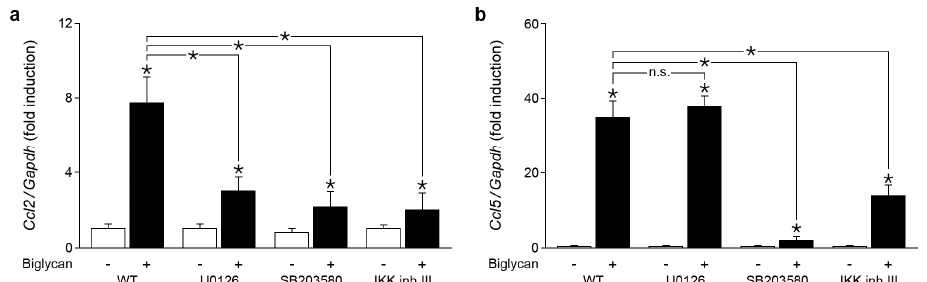
Figure 4. Biglycan triggers expression of Ccl2 and Ccl5 mRNA in Erk1/2-, p38 MAPK and NF- κ B-dependent manner. ( a , b ) qPCR analysis for mRNA levels of: ( a ) Ccl2; and ( b ) Ccl5 in WT macrophages stimulated with biglycan (4 µ g/mL, 2 h) with and without MEK/Erk inhibitor U0126 (10 µ M), p38 MAPK inhibitor SB203580 (10 µ M), and IKK inhibitor III (10 µ M). The inhibitors were applied 30 min prior to the biglycan stimulation. mRNA expression was normalized to Gapdh and given as fold induction of untreated WT controls. Data are expressed as means ± SD. n = 3 individual experiments; * p < 0.05; n.s. = not significant. Erk1/2: extracellular signal-regulated kinase; p38 MAPK: p38 mitogen-activated protein kinase; IKK: I κ B kinase; inh: inhibitor.